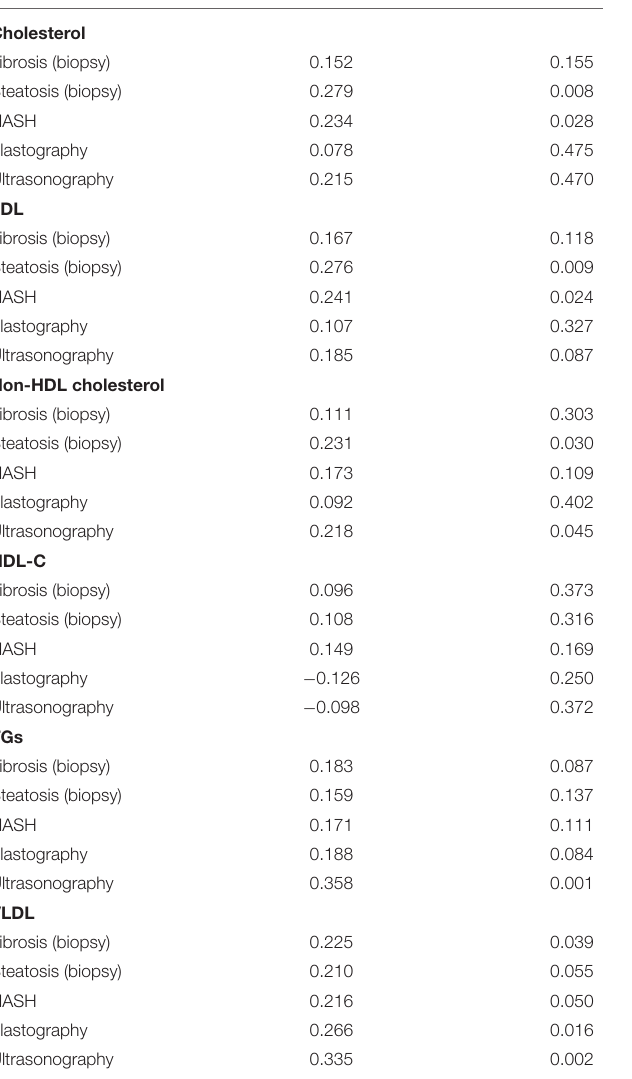
TABLE 3 | Correlation coefficient between